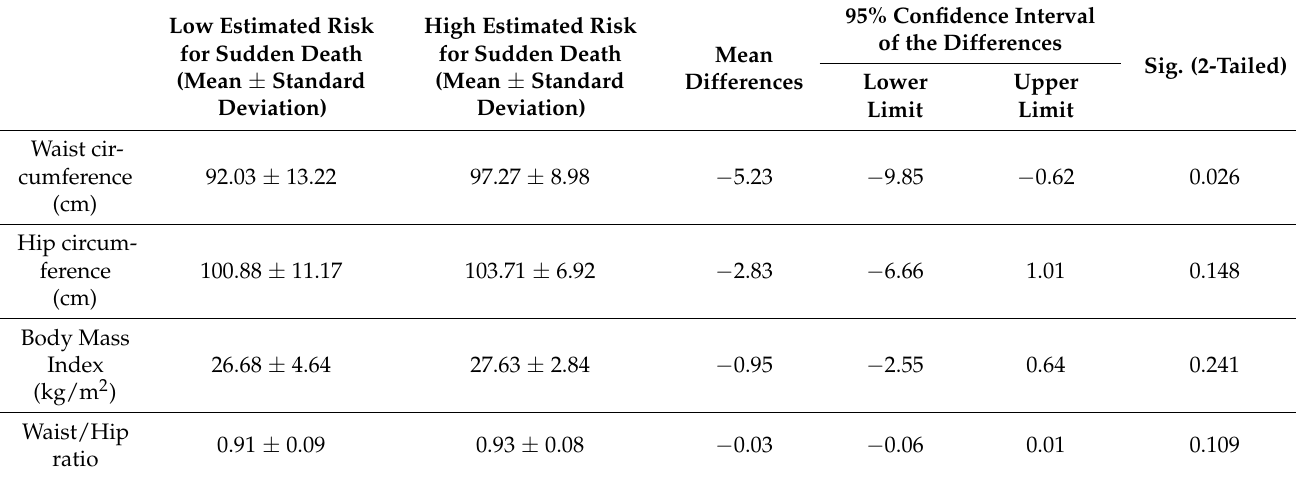
Table 3. Descriptive and comparative analysis of anthropometric characteristics of the investigated